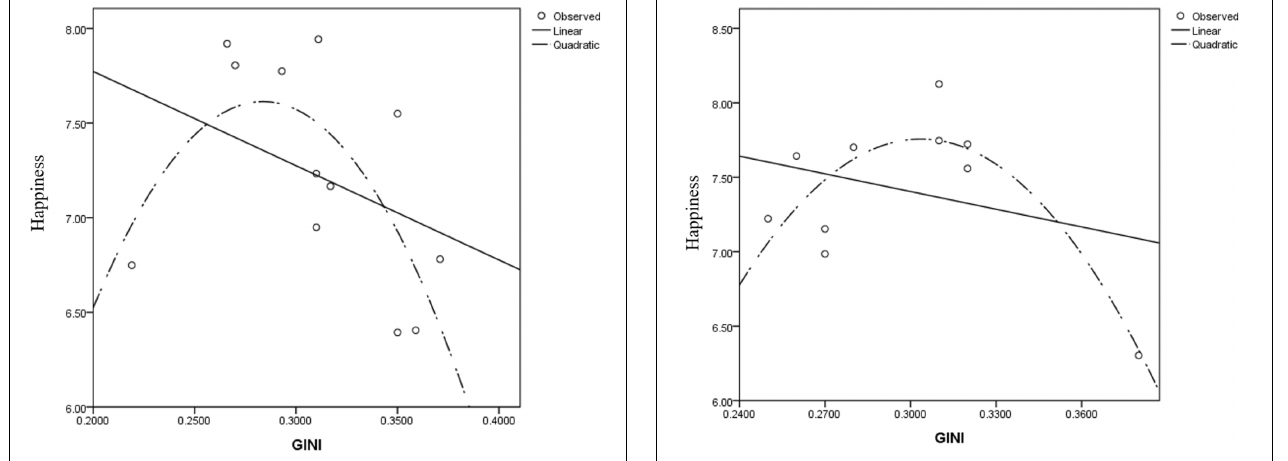
FIGURE 5 | Scatter plot of GINI-happiness for ESS,